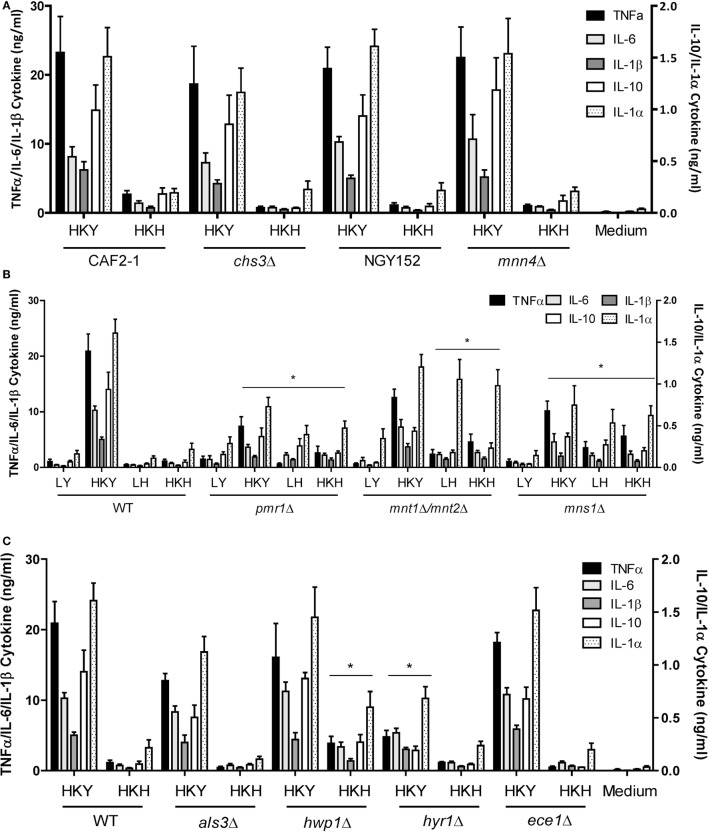
Cytokine production stimulated by cell wall mutants of yeast and hyphal cells. (A) Cytokine production stimulated by human PBMCs with LY—live yeast; HKY—heat-killed yeast; LH—live hyphae; HKH—heat-killed hyphae; Candida albicans mnn4Δ and chs3Δ and control strains, NGY152 and CAF2-1. (B) Cytokine stimulation with mannosylation defective mutants, pmr1Δ, mnt1Δ/mnt2Δ, and mns1Δ. (C)
als3Δ, hwp1Δ, hyr1Δ, and ece1Δ. Results presented as mean ± SEM (n = 6), and the asterisks indicate comparison of the wild-type values and the mutant strains (*p < 0.05).